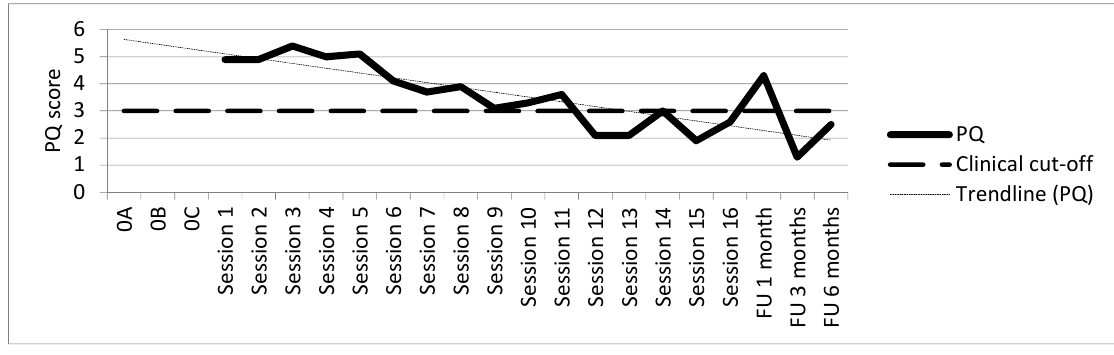
Figure 2: Deborah’s weekly personal problems (PQ) score Note . The first available score was in session 1. 0A, 0B and 0C = assessment sessions. FU = follow-up. PQ = Personal Questionnaire (Elliott, Shapiro, & Mack, 1999).